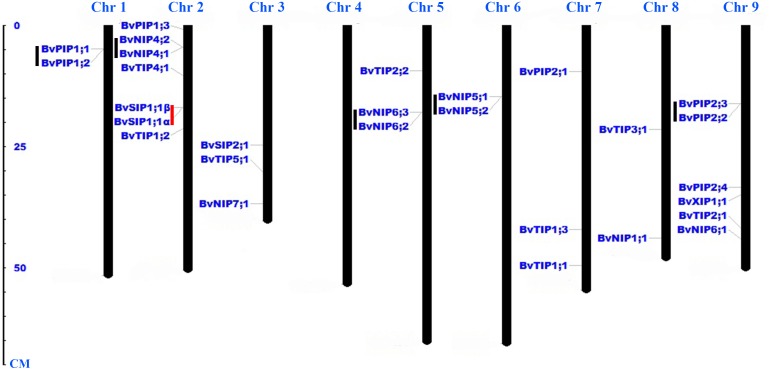
Distribution of BvAQP genes on the nine B. vulgaris chromosomes.Note: Black lines represent tandem gene duplications. Red lines represent the existence of different transcripts from single gene.